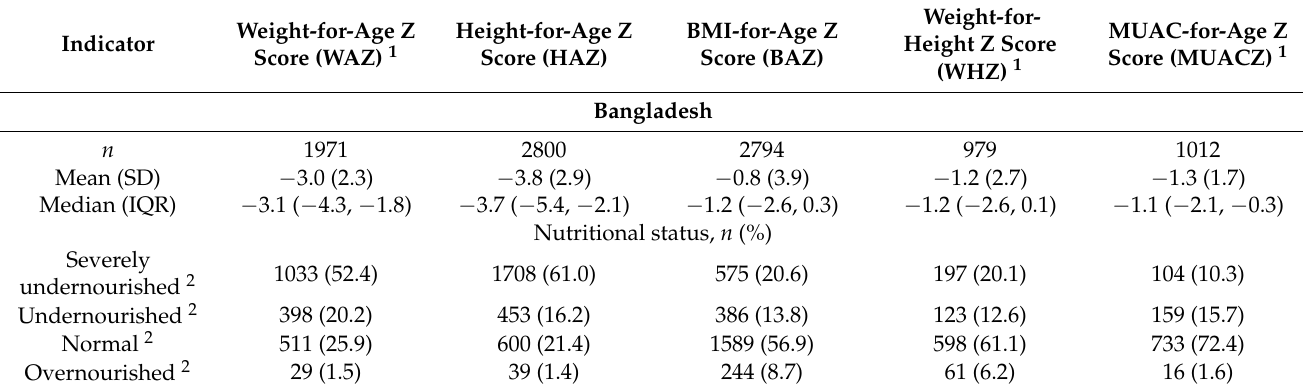
Table 1. Nutritional status of children with CP registered in the GLM